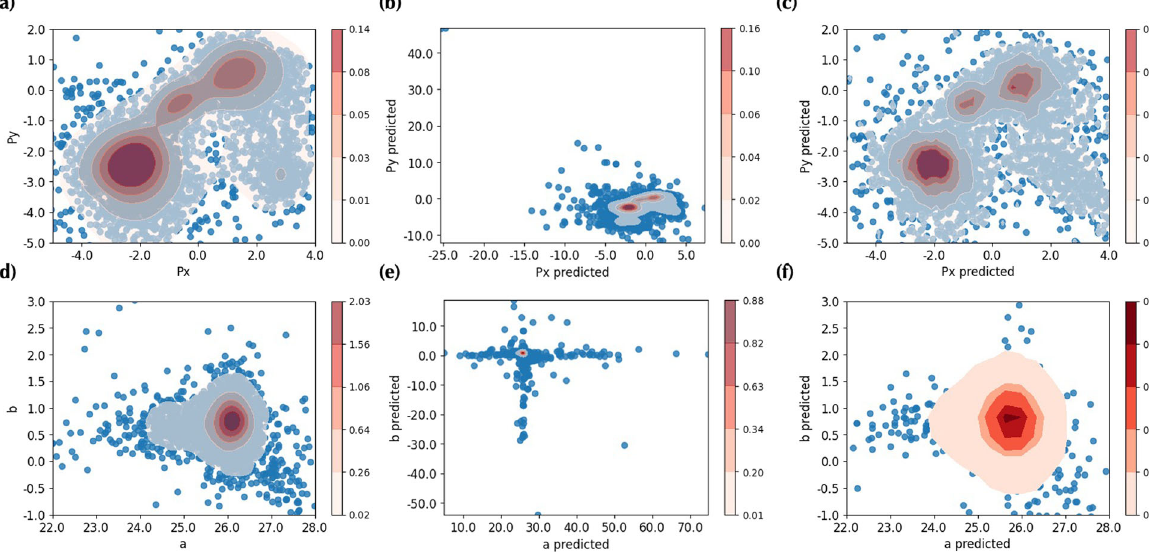
Fig. 3 DCNN-predicted cell parameters. Joint distribution of P x vs. P y components a measured, b DCNN-predicted, and c zoomed-in of b . Joint distribution of lattice parameters, a and b, d measured, e DCNN-predicted, and f zoom-in in e